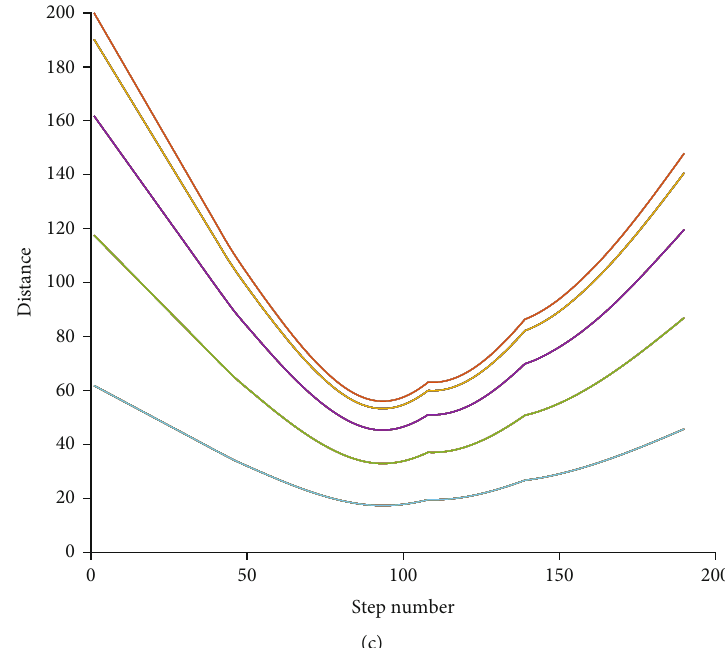
Figure 11: Con fl ict resolution strategies based on APF-GA: (a) 2 UAVs ’ con fl ict, (b) 6 UAVs ’ con fl ict, and (c) 10 UAVs ’ con fl